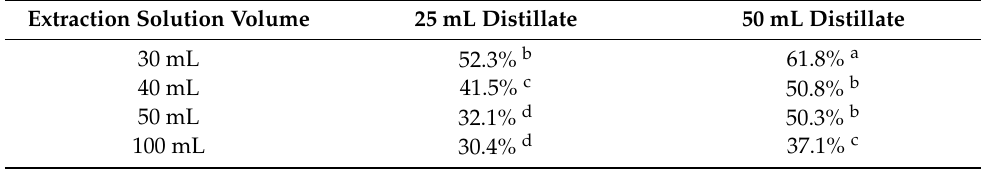
Table 1. Recovery of MA under varying process parameters during steam distillation. Extraction Solution Volume 25 mL Distillate